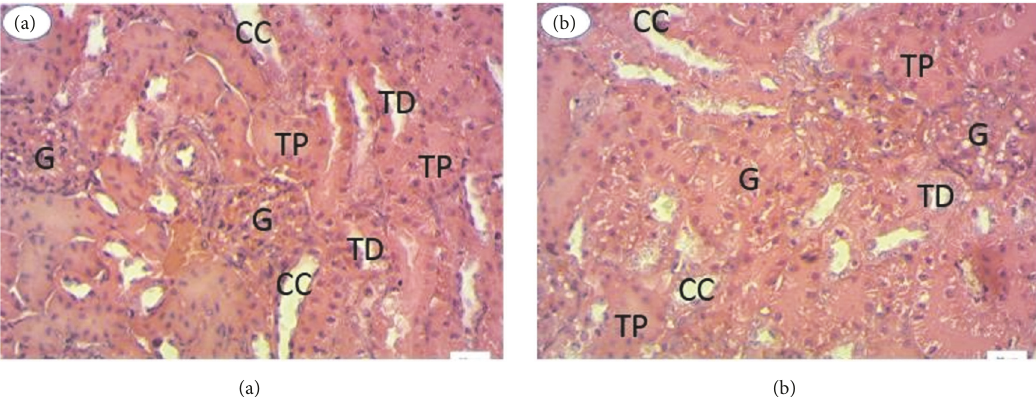
Figure 6: Renal histology, 400x magnification. (i) CC: collecting ducts. (ii) G: the glomeruli. (iii) TP: the proximal tubes. (iv) TD: the distal